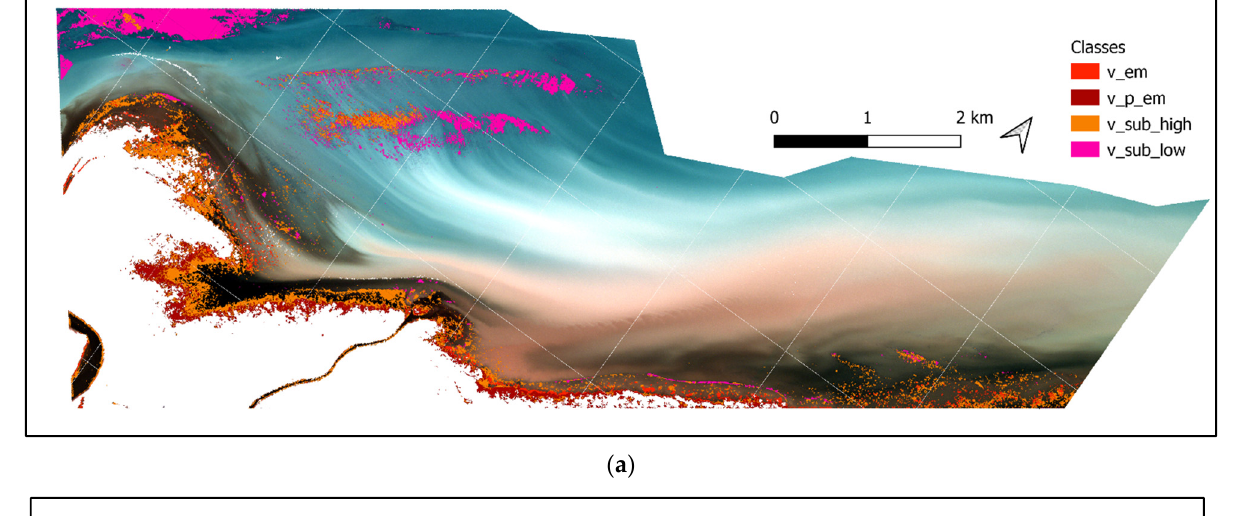
classification attempt, where the main difficulty was to prevent overestimation of vegetated areas